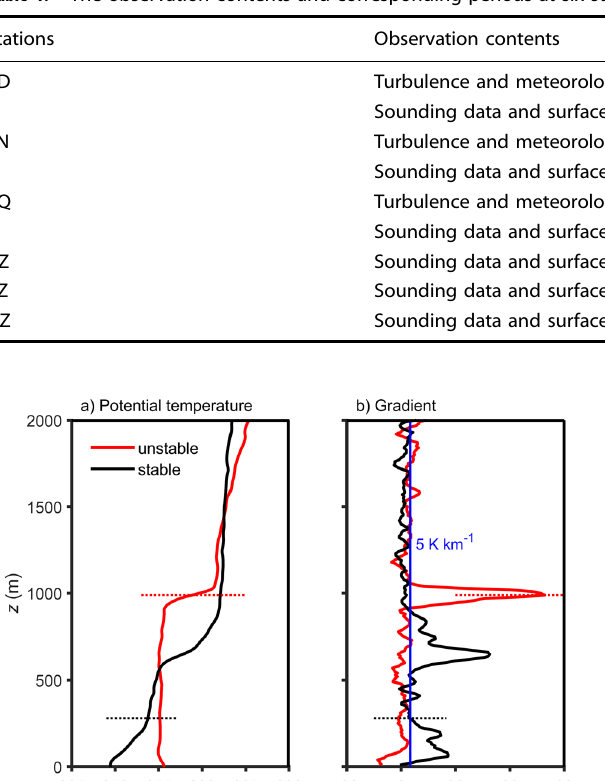
Table 1. The observation contents and corresponding periods at six stations.